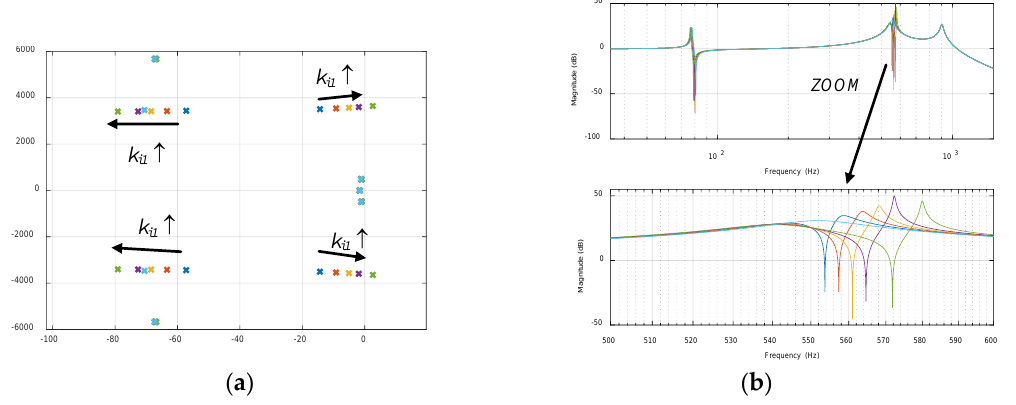
Figure 12. Dominant poles and Bode plots of the voltage at the Pcc with different k i 1 values (multiplied by factors (1 2 3 4 6) from its initial value). Active resistance is constant R v 1 = 7.562 k Ω programmed at 550 Hz. ( a ) Dominant poles of the system, ( b ) Bode plot of v 3 αβ ( s )/ v sαβ ( s ).